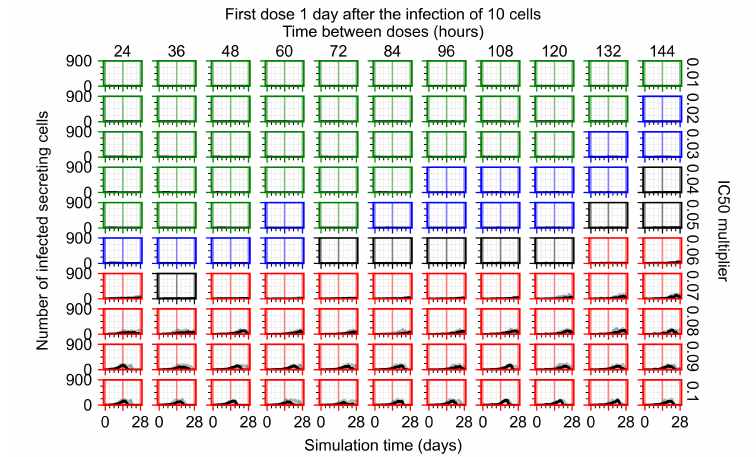
Figure A23. Infected (secreting extracellular virus) population.